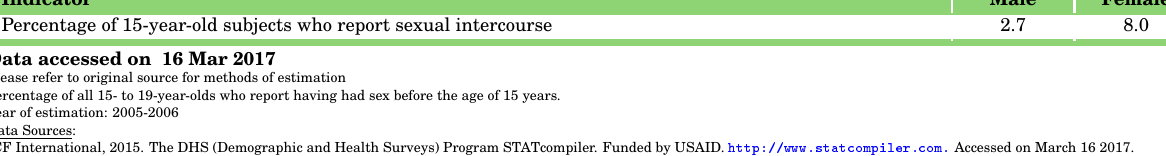
Table 40: Percentage of 15-year-olds who have had sexual intercourse in India Indicator